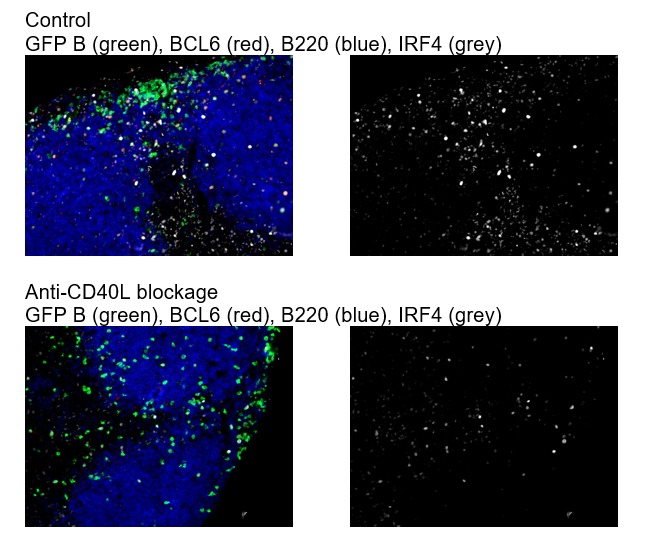
DOI:
http://dx.doi.org/10.7554/eLife.19552.019